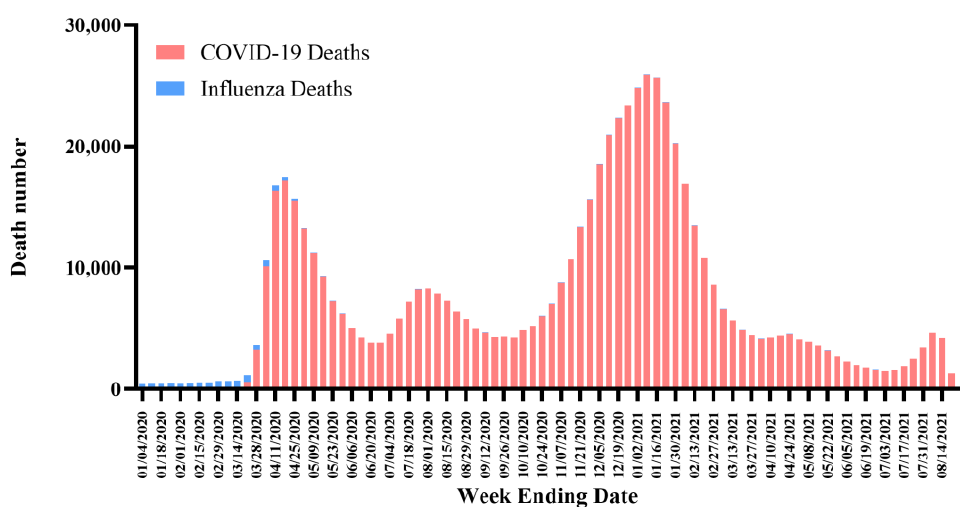
Figure 1. Weekly death analysis of COVID-19 and influenza in the USA. Data may lag by an average of 1–2 weeks, so the trend of decline in recent weeks may not accurately reflect the current situation. Available online: https://data.cdc.gov/NCHS/Provisional-COVID-19-Death-Counts-by- Week-Ending-D/r8kw-7aab (accessed on 24 August 2021).